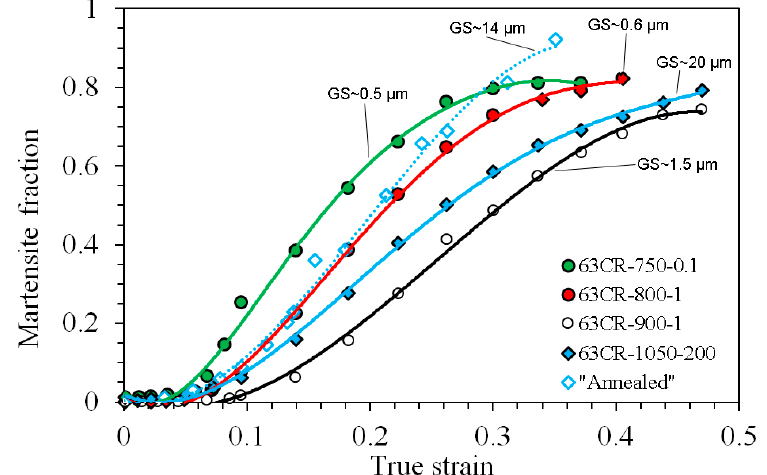
Figure 11. Examples of DIM evolution during tensile testing in various 301LN (M d30 = 27 °C) structures [82‚85,87] and coarse-grained annealed 301LN with M d30 = 37 °C from Reference [155]. Legend: Reduction (%CR), temperature (°C), duration (s).